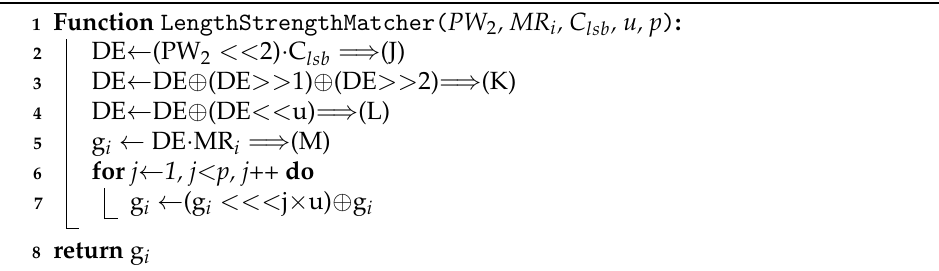
Algorithm 5: Pseudo-code of